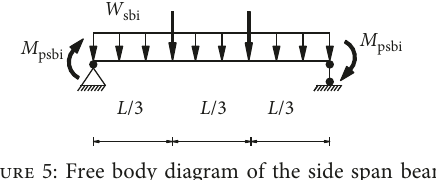
Figure 5: Free body diagram of the side span beam.